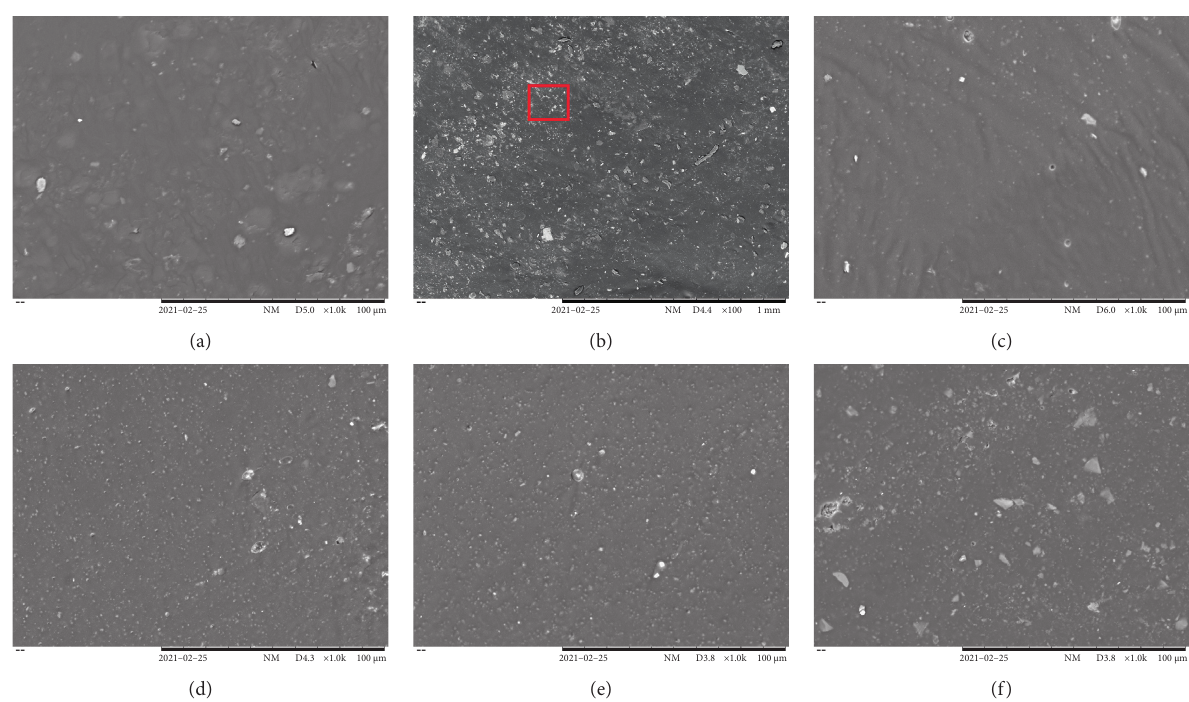
Figure 6: SEM images of modified and unmodified bitumen samples.